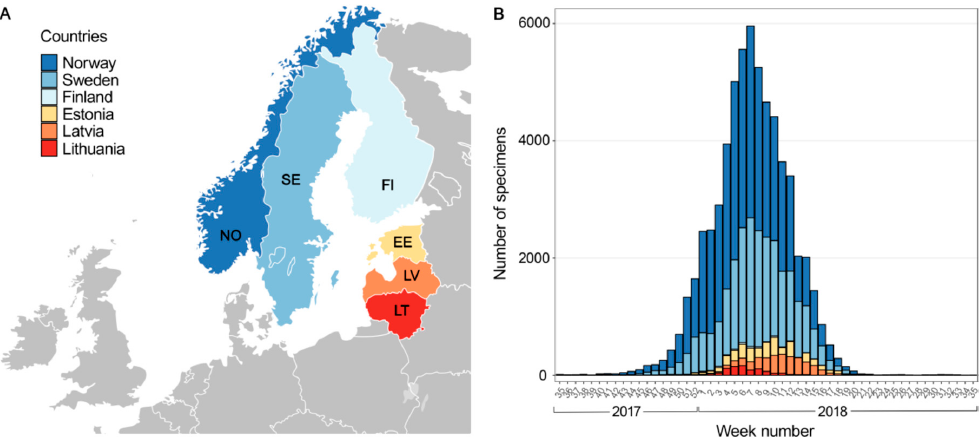
Figure 1. Weekly number of detections of influenza viruses in six Northern European countries, 2017–2018. ( A ). Map showing six Northern European countries included in the analysis. A blank map of Europe in SVG format from Wikimedia Commons, was used as a template. ( B ) Stacked bar chart representing the number of influenza-positive specimens distributed across six countries between week 35 of 2017 and week 34 of 2018. Each country is shown as a bar in the same color as (A).